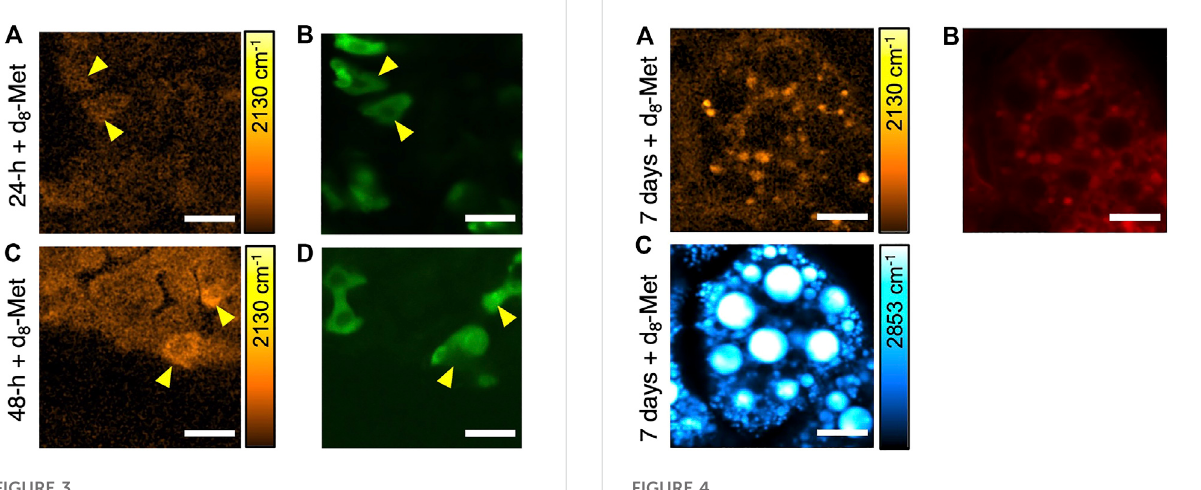
FIGURE 3 The uptake of d 8 -Met in fi xed Drosophila adult gut cells varies by cell type. SRS images of d 8 -Met uptake (orange) after feeding on d 8 - Met food for 24 h (A) and 48 h (C) . Yellow arrowheads indicate cells with high d 8 -Met signal (A, C) and their corresponding esg directed GFP expression (green) (B, D) . The color bars corresponding to the d 8 -Met concentration shows maximum values of (A) 43 mM and (C) 45 mM. Scale bars, 25 μ m.